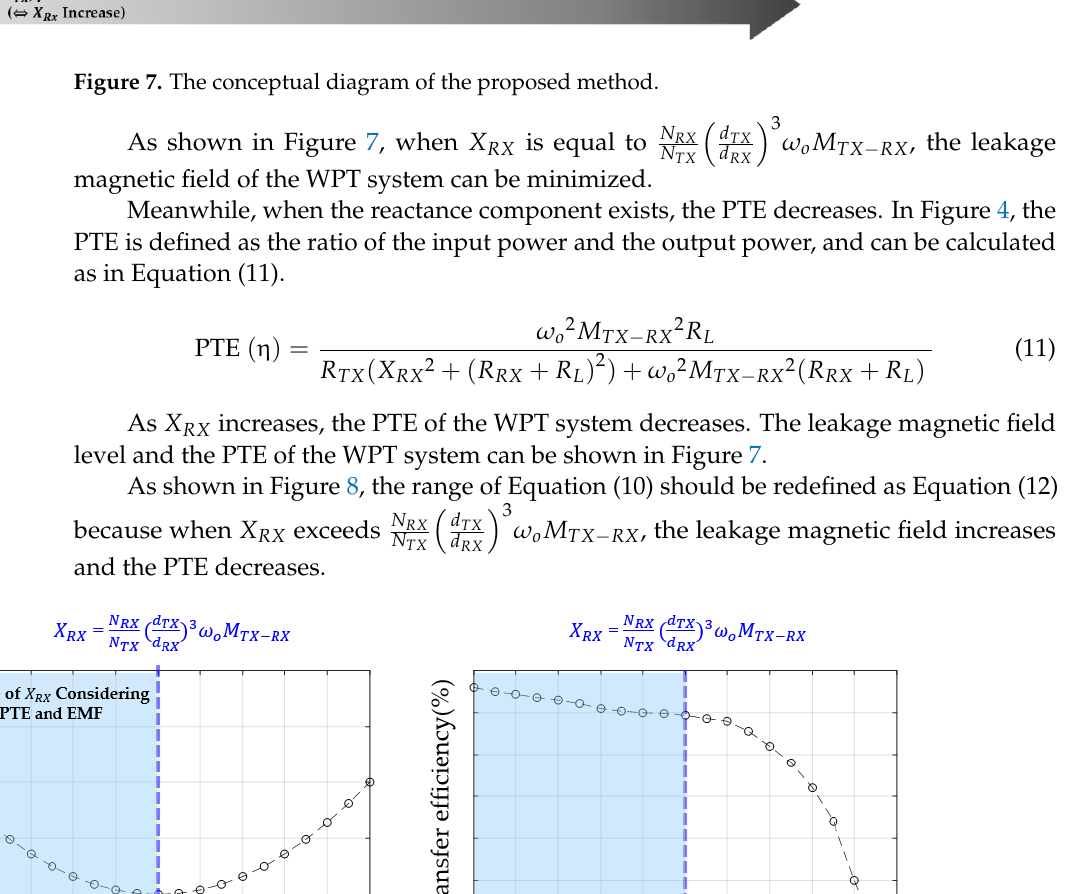
Figure 7. The conceptual diagram of the proposed method.